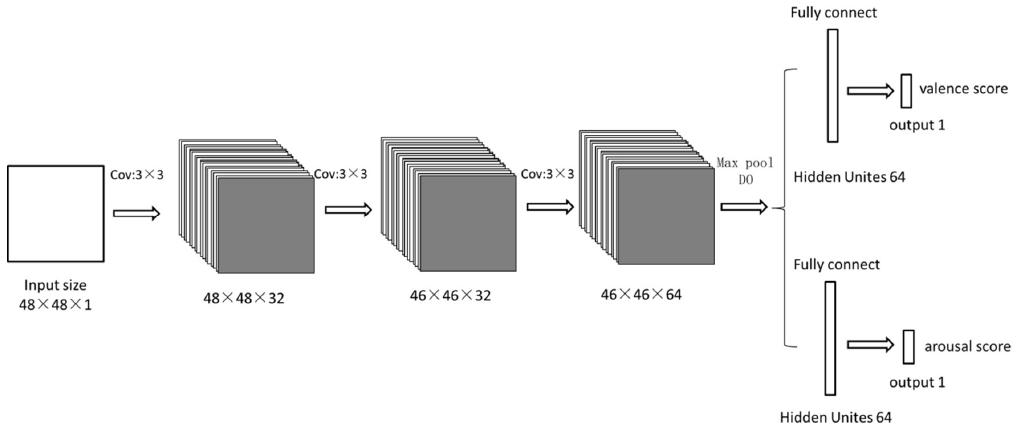
Figure 2. The CNN network for multitask classification; “DO” indicates that the layers drop out [15]. Note that we apply padding in each layer except the second layer. Therefore, excluding the second layer, the output of each layer is of the same size as the previous layer.